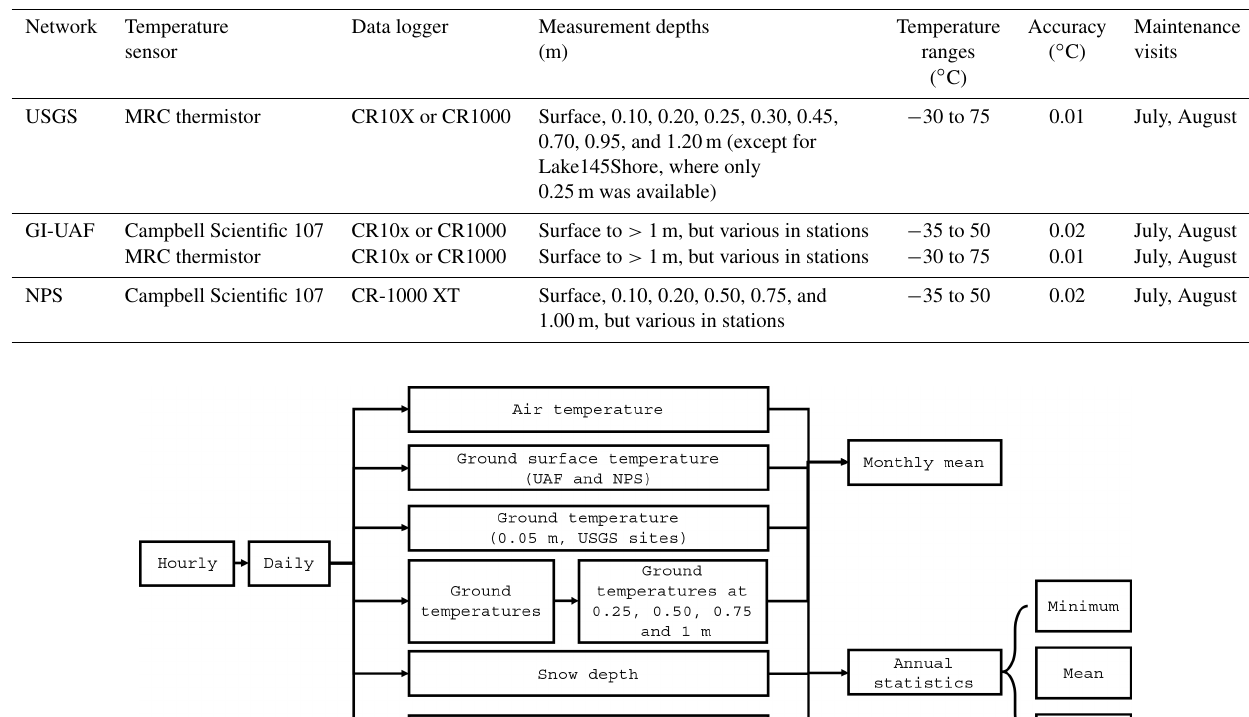
Table 3. Summary of ground temperature instruments from the USGS, GI-UAF, and NPS networks of Alaska, USA.